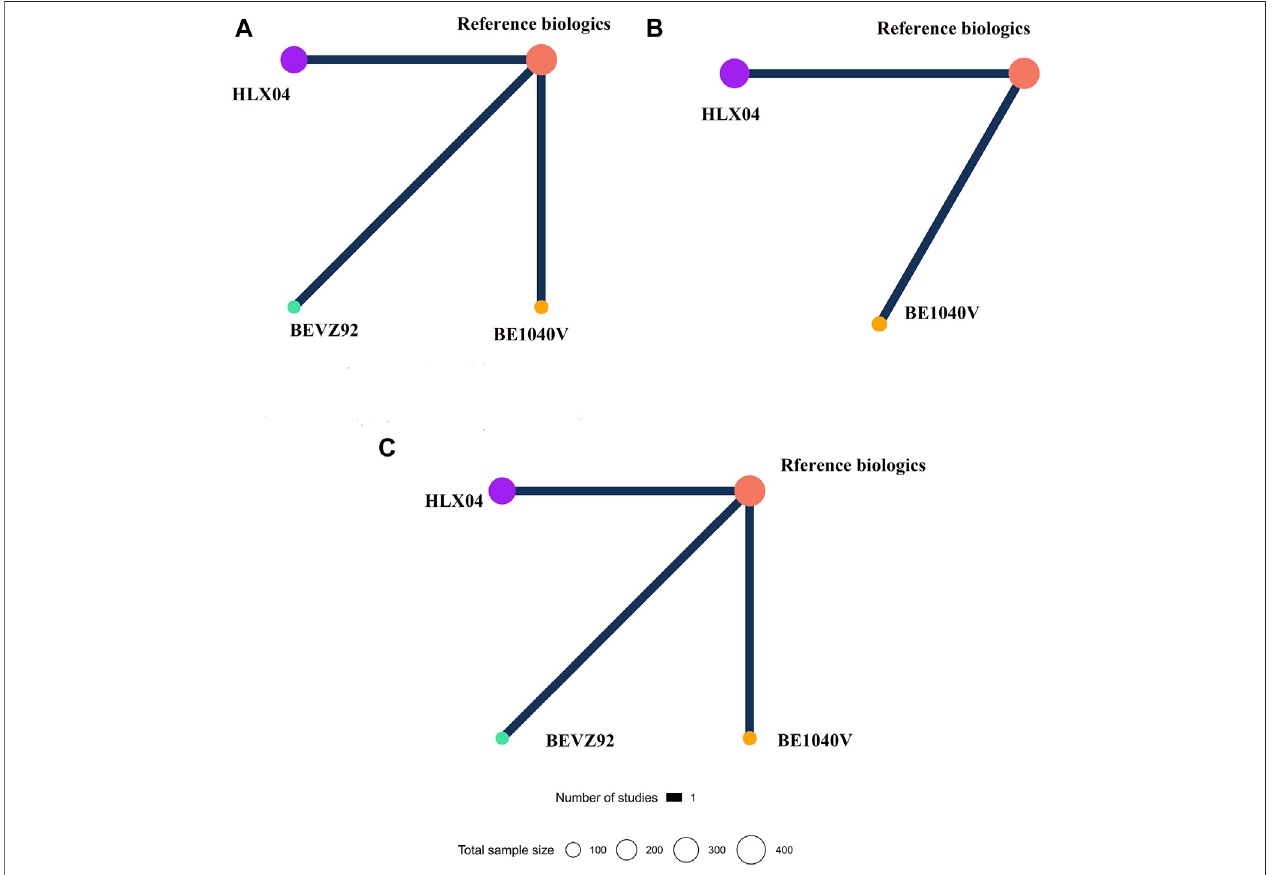
FIGURE 6 | Network plots for different biosimilars and reference biologics in colorectal cancer patients. (A) Objective response rate. (B) Overall survival. (C) Incidence rate of grade 3 – 5 adverse events. Different colors of nodes indicated different treatments. The size of nodes corresponded to the number of participants investigating treatment. The thickness of the edge represented the number of trials. The lack of lines suggested that there are no head-to-head trials for this outcome between the two treatments.